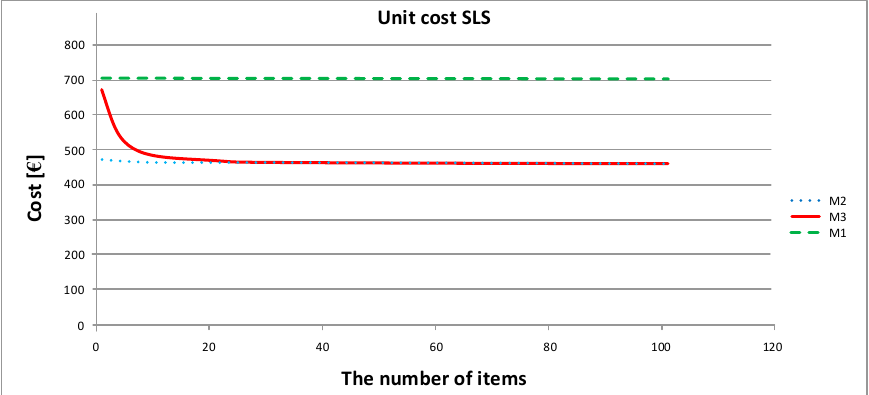
Figure 12. Dependence of the costs of bracket production on the number of prototypes for PJM technology.